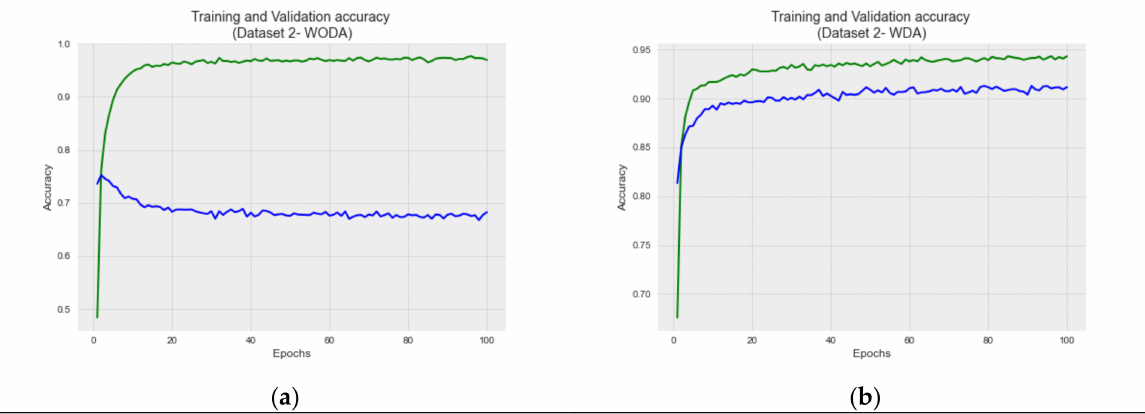
Figure 15. Bi-LSTM model validation and testing accuracy and loss using dataset 2: ( a ) model accuracy (WODA); ( b ) model accuracy